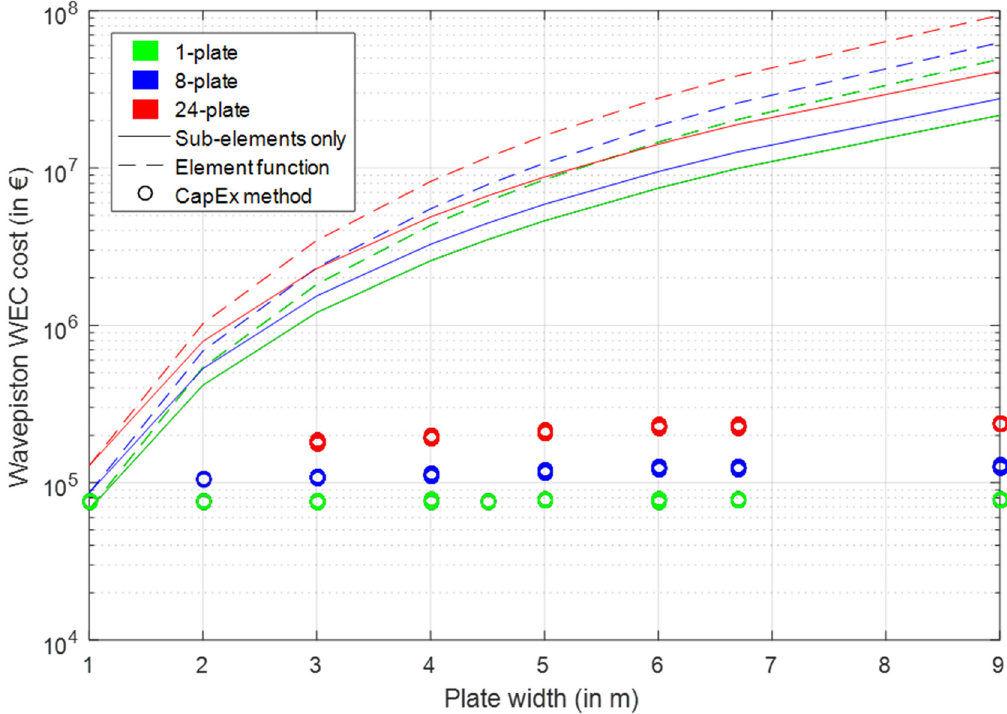
Figure 7. Wavepiston WEC cost (in €) using the Similitude method over the plate width for the “Sub-element only” and “Element function” weighted scale coefficient results from the CapEx method for the three values of number of plates from the dataset.